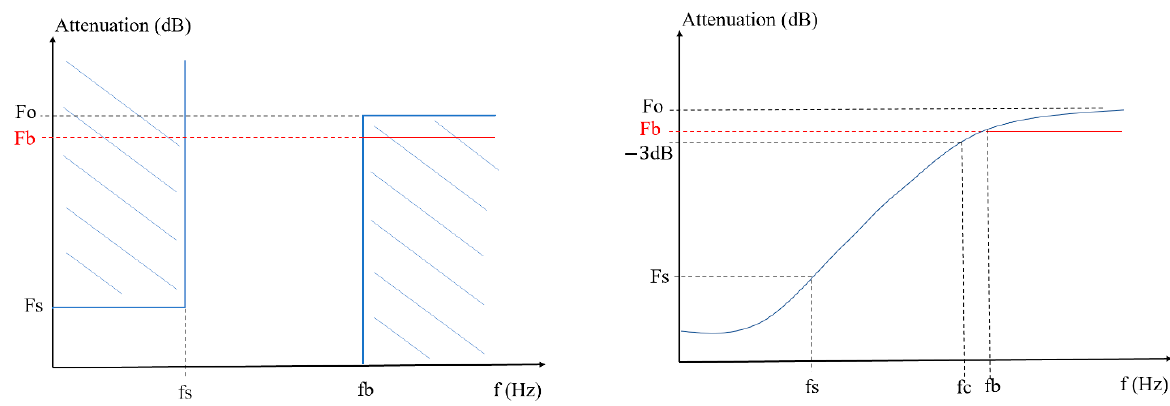
Figure 4. Main characteristics of the coupling system with MV network.